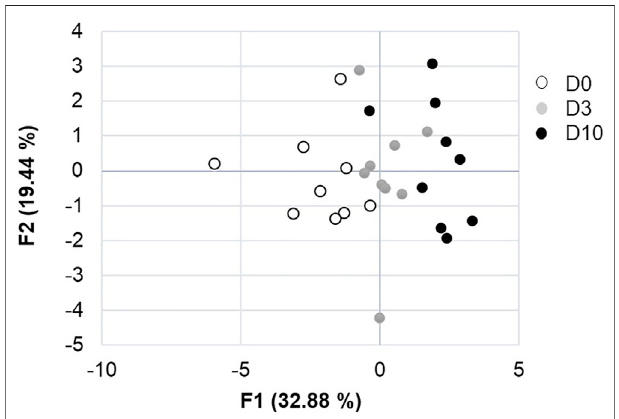
FIGURE 4 | Analysis of principal components of the effect of storage duration on egg parameters. F1 and F2 axes explain 52.2% of the variability between D0, D3 and D10